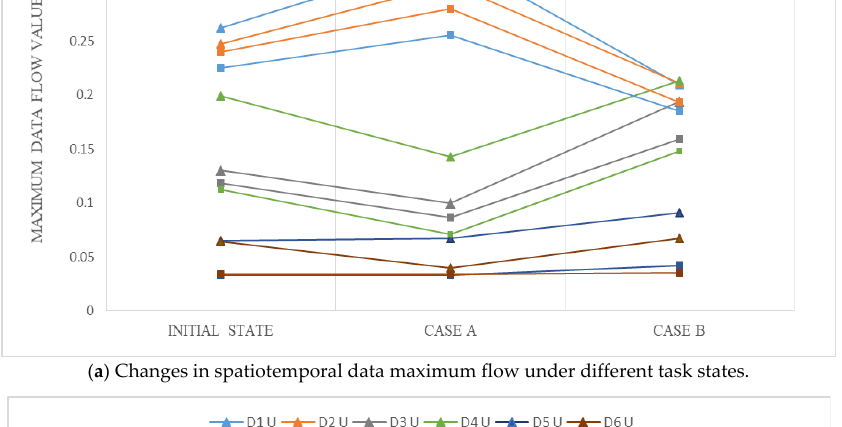
Figure 11. The real-time throughput monitoring curves of 𝐷 3 , 𝐷 4 and 𝐷 5 .